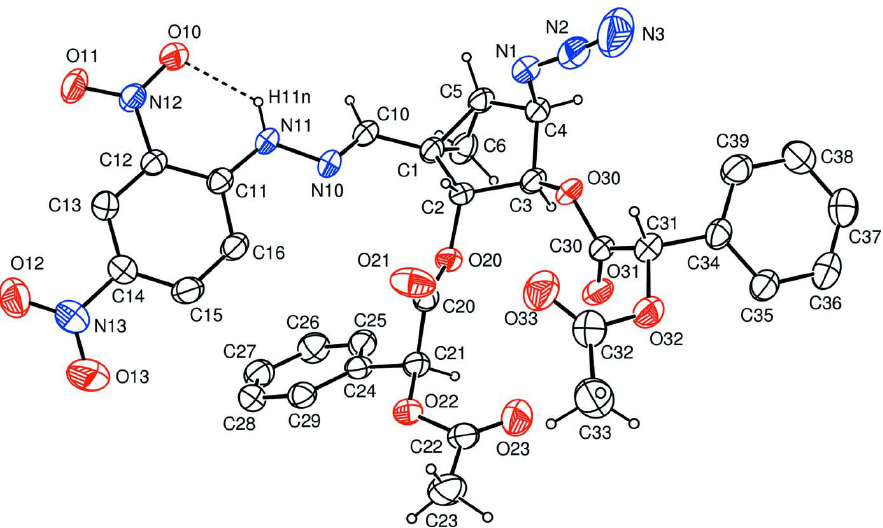
The title compound with numbering scheme used. Hydrogen bonding interactions shown as dotted lines. Ellipsoids are drawn at the 50% probability level. Hydrogen atoms of aromatic-groups have been omitted.